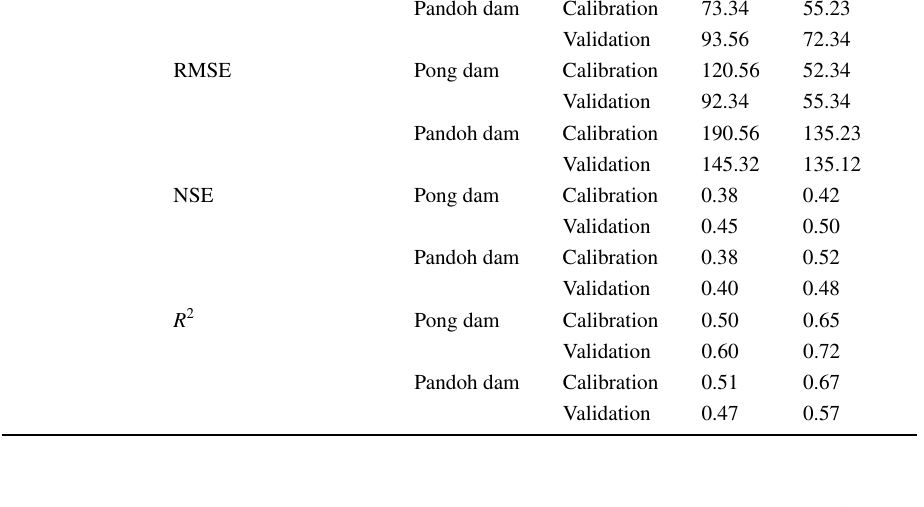
Fig. 15 Observed and simulated monthly sediment yield for model calibration (1993–1996) of Pong dam for a ERA-Interim and b IMD weather